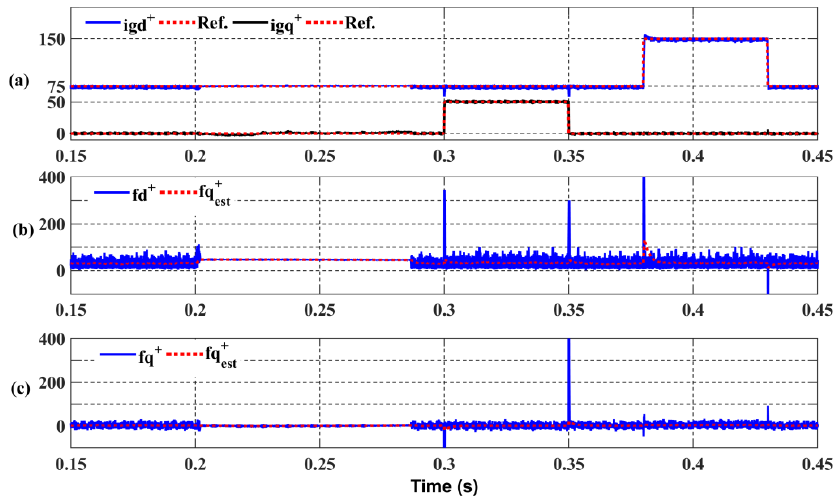
Figure 9. Simulation B results with dual positive- and and negative-sequence controllers: ( a ) positive-sequence dq axis currents (A), ( b ) f gd+ and f̂ gd+ (V), and ( c ) f gq+ and f̂ gq+ (V).